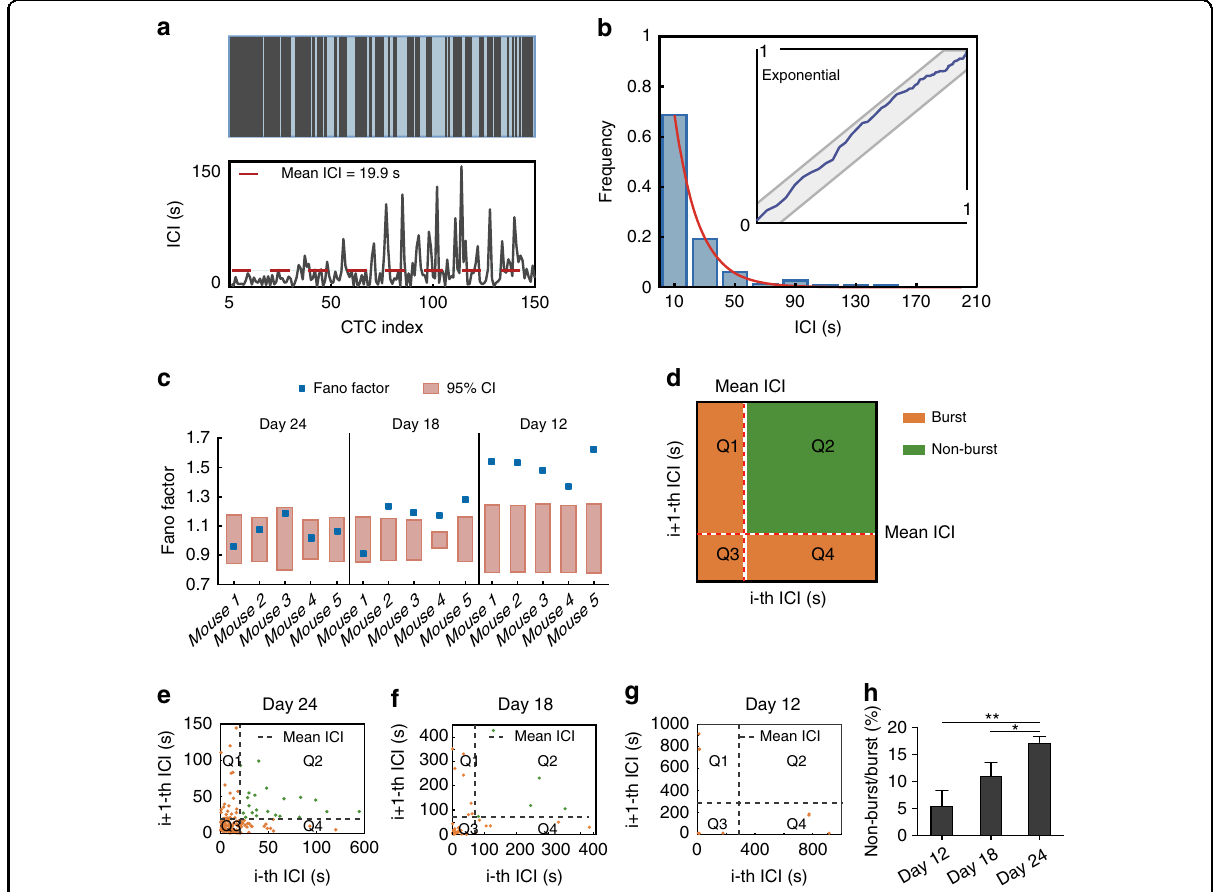
Fig. 2 Analysis of the pattern of CTC occurrence at short timescales by fl uorescence IVFC. a Upper, 151 CTCs detected in 3000 s in a mouse at 24 days after tumor implantation. Lower, ICI of each CTC. The red dashed line shows the average ICI. CTC index is the CTC serial number. b ICI histogram with time bins size = 20 s. The inset shows the KS plot of ICIs stays within the 95% con fi dence band (CI) (gray band), indicating the ICIs follow an exponential distribution. c The Fano factor of each mouse on day 24, day 18, and day 12 after tumor implantation. The orange boxes indicate the 95% con fi dence intervals of the Fano factors in a Poisson process. The small blue boxes indicate the Fano factor of each mouse. d Diagram of the joint ICI plot. e – g Joint ICI scatter plot on day 24 ( e ), day 18 ( f ), and day 12 ( g ). The x- axis shows the current ICI, and the y- axis shows the next ICI. The dashed line indicates the mean ICI. h The ratio of nonbursts to bursts on day 12, day 18, and day 24; n = 5 mice, unpaired t -test. * P < 0.05, ** P < 0.01. All data are presented as the mean